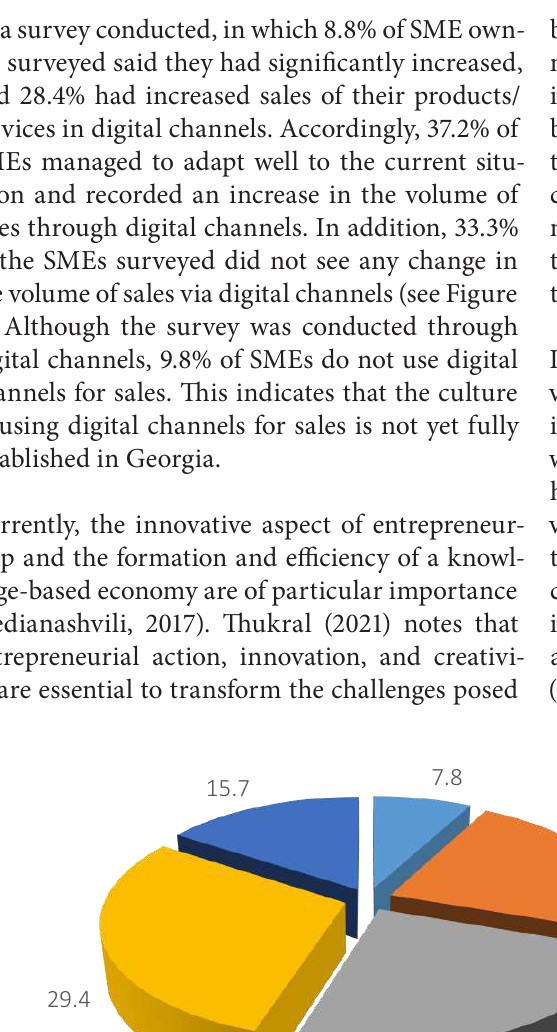
Figure 1. Main challenges of SMEs during the pandemic in Georgia (%)